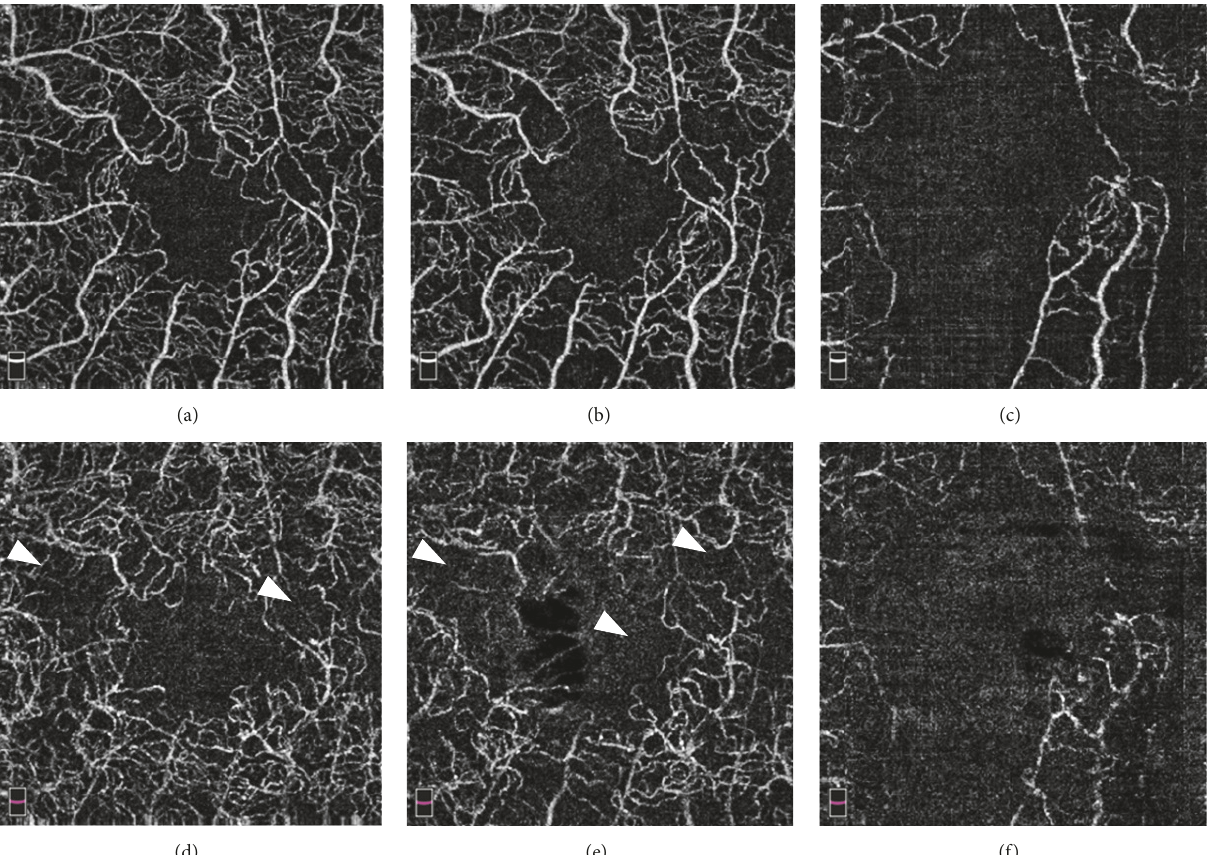
Figure 4: OCTA images of the SCP in the left eye (a) 1 month, (b) 2 months, and (c) 4 months after the initial visit. OCTA images of the DCP in the left eye (d) 1 month, (e) 2 months, and (f) 4 months after the initial visit. OCTA images demonstrating expanding nonperfusion area in both SCP and DCP. In DCP, extensive avascular areas are recognized earlier than in SCP